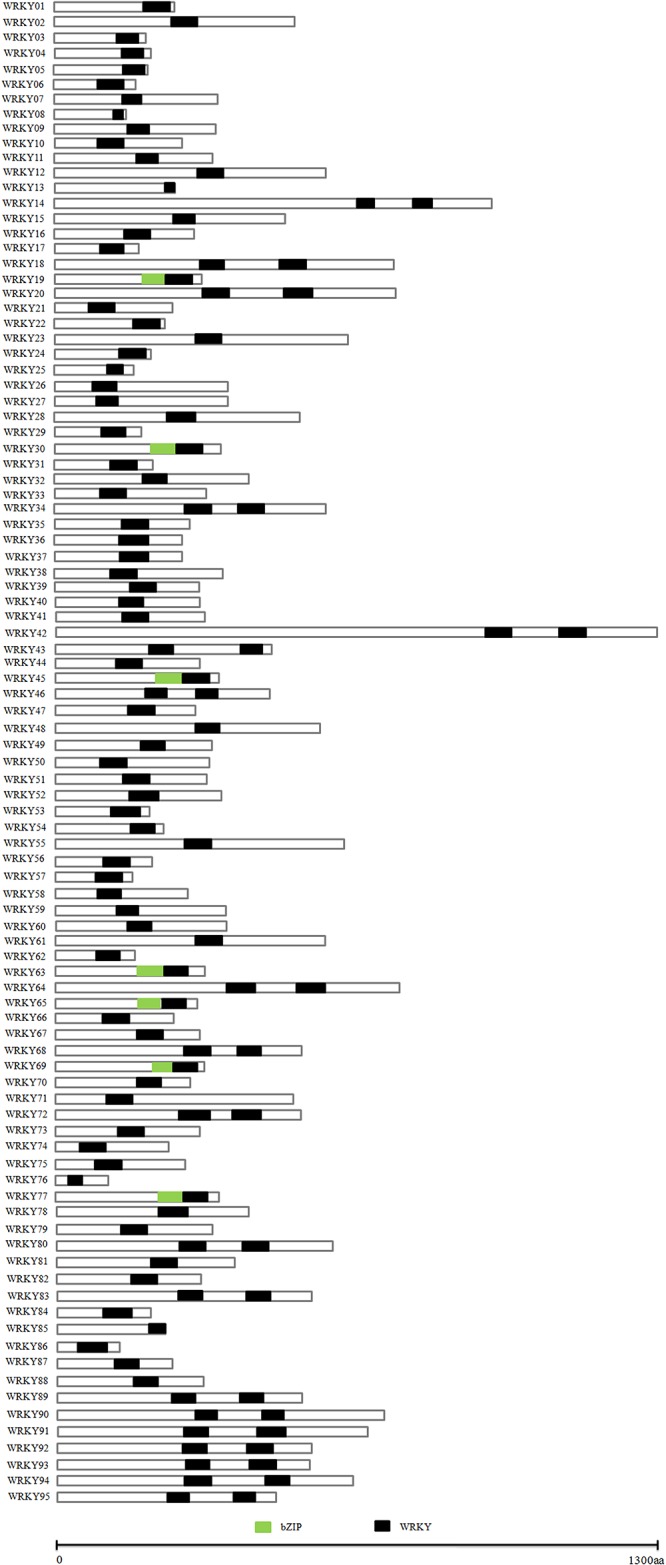
Schematic representation of conserved motifs in 95 EgWRKY genes.All motifs were identified by MEME with the full-length amino acid sequence of 95 EgWRKY in Elaeis guineensis. The size of each EgWRKY were displayed proportionally. WRKY and bZIP motif were indicated using different colour box.